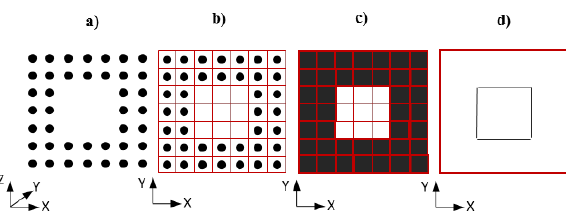
Figure 2: a) Point cloud, b) Point cloud projected into a rectangular matrix, c) Binarized image, d) Edge